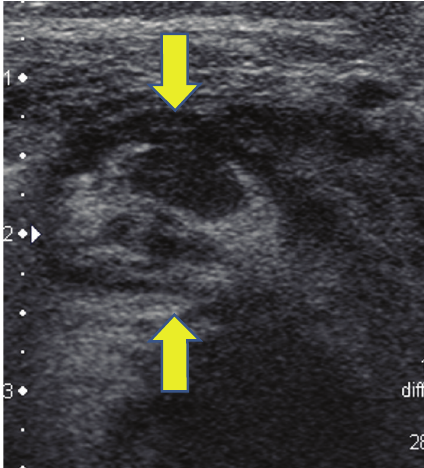
Figure 1: Selected gray-scale axial ultrasound imaging of the right forearm soft tissue mass. A heterogeneous echogenic mass is demonstrated along the ventral forearm musculature displacing, rather than invading, surrounding structures (arrows).